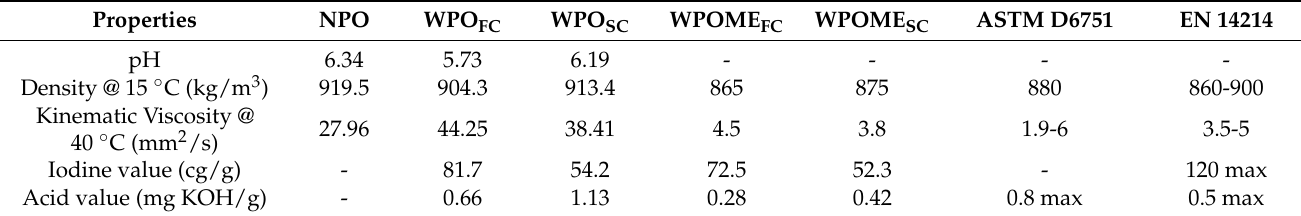
Table 4. Physicochemical properties of